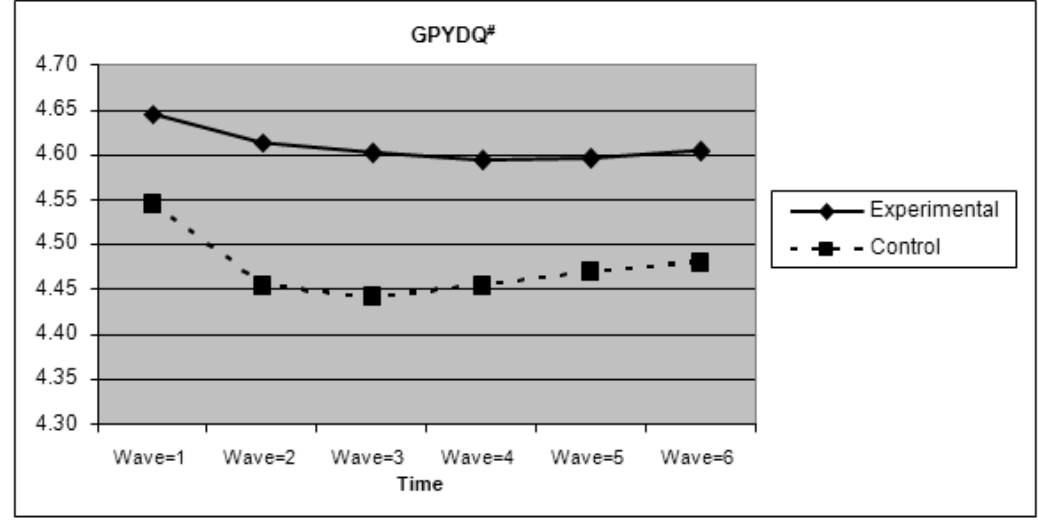
FIGURE 8. Growth trajectories of the experimental participants Δ and control participants using GPYDQ # as an outcome indicator. Δ Experimental participants who regarded the program as beneficial. # General positive youth development qualities second-order